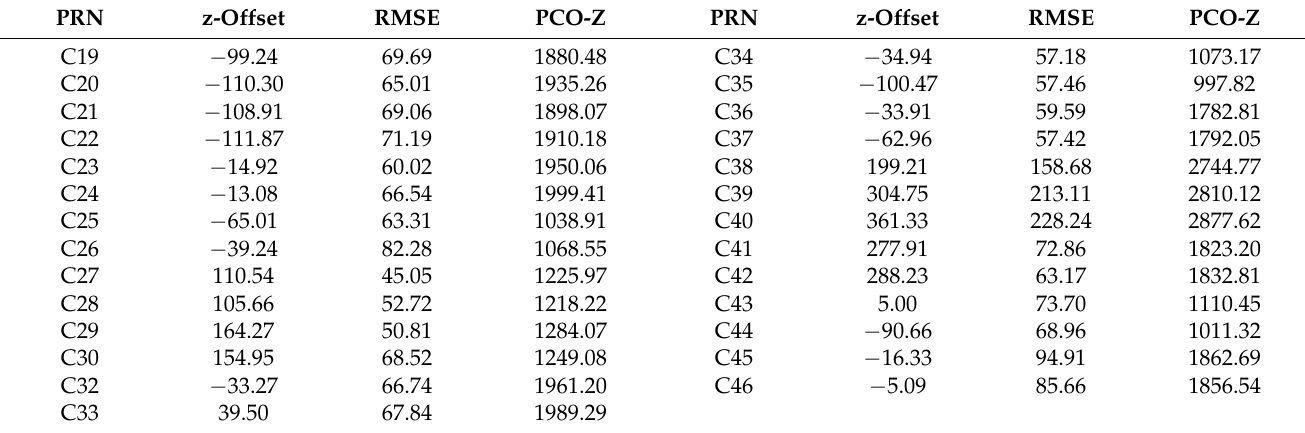
Figure 6. The initial PCO-Z, z-offsets, and the final PCO-Z. The z-offset is the correction of the initial PCO-Z, and the sum of the z-offset and initial PCO-Z is the final PCO-Z. 4.2. PCO-Z and PCVs The PCVraw of the 3-Step Scheme is estimated with the PCO z-offset fix to Table 2, while the 2-Step Scheme fix to CSNO published values. Take C23, C29, C40, and C46 as examples, Figure 7 shows their daily PCVraw of the 2-Step Scheme, and the PCVraw of the 3-Step Scheme shows similar behavior. It can be seen that the consistency of daily PCVraw at the minimum and maximum nadir-angle are worse than the others, that is because only a few observations are available at these nadir-angles, and the weight of observations at the maximum nadir-angle is weak, the same phenomenon can also be seen